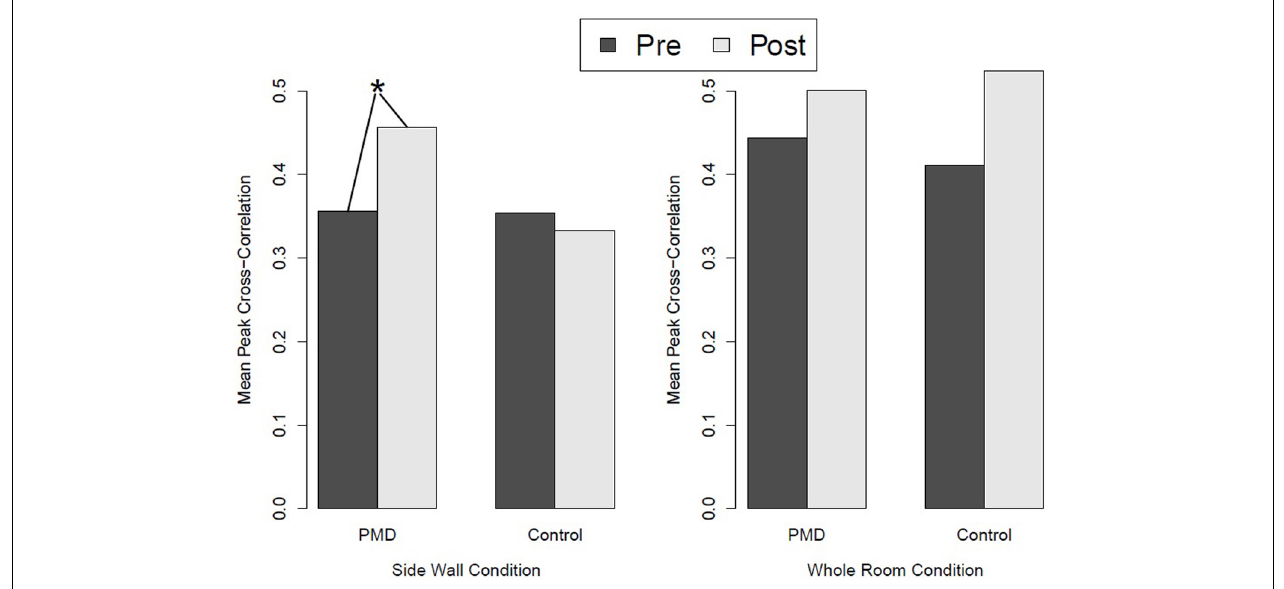
FIGURE 5 | Responsiveness to peripheral optic flow and global optic flow in the moving room in infants who received powered-mobility-device (PMD) training and those who did not. ∗ p < 0 .